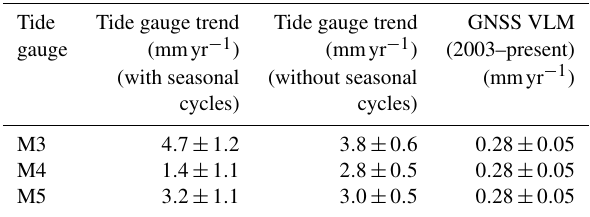
Table 2. Relative sea level trends (mmyr − 1 ) recorded by the M3, M4 and M5 tide gauges (estimated with and without the seasonal cycles), as well as the GNSS-based vertical land motion (mmyr − 1 ) at the Senetosa